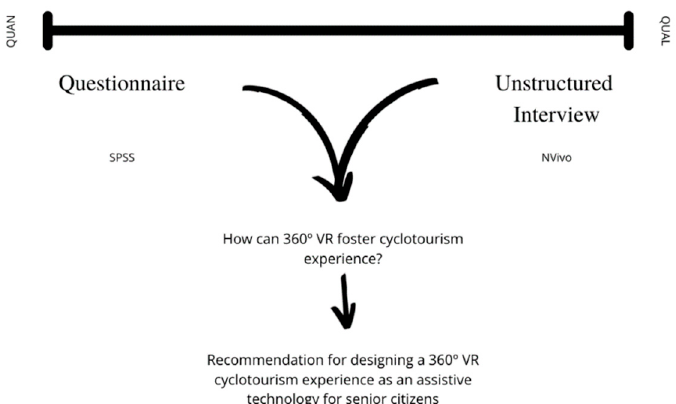
Figure 1. Schematic overview of the convergent parallel mixed-method approach.